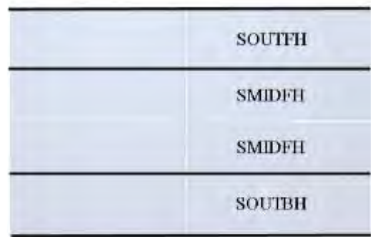
Figure 1 . Serve placement